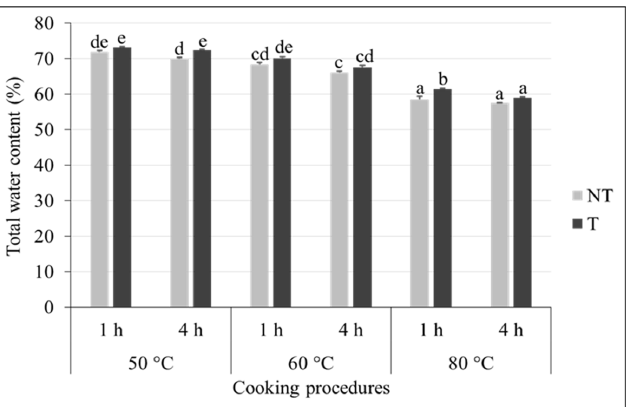
Figure 5. Total water content (TWC) values measured on bovine Semitendinosus muscle samples previously tumbled (T) or not (NT, used as control) and then sous-vide cooked at 50 ◦ C, 60 ◦ C